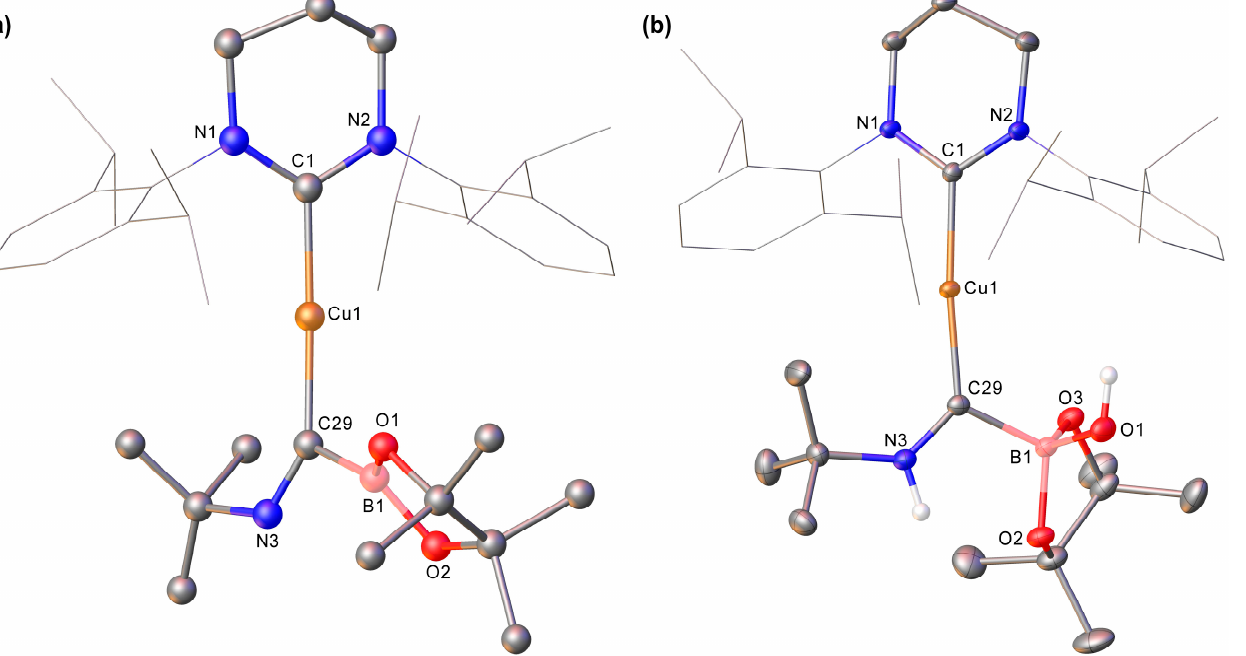
reported reactivity towards heterocumulenes.